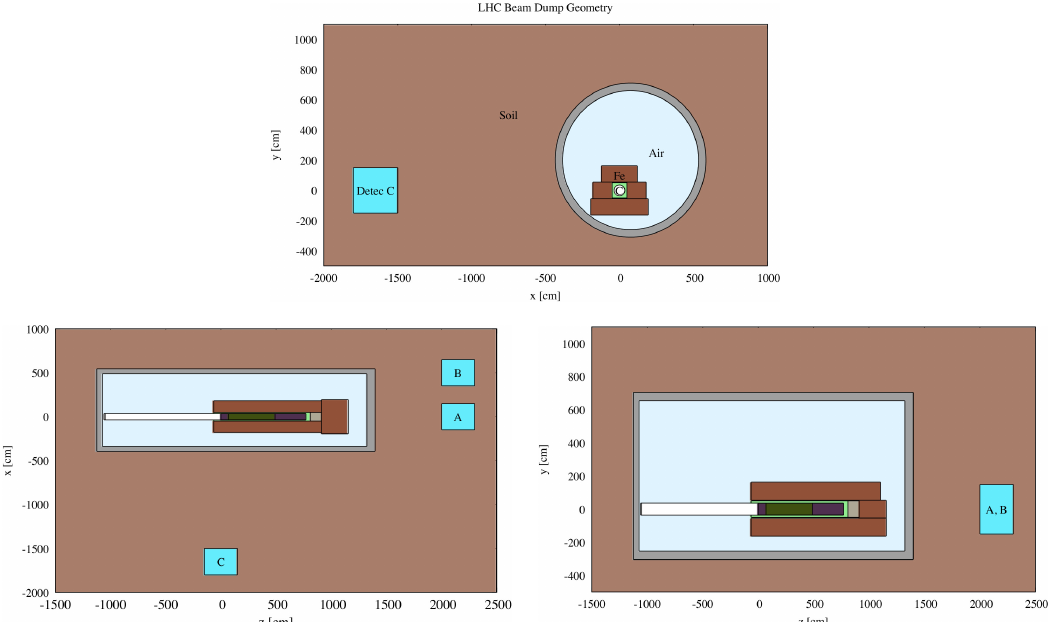
Figure 1. Simplified view of the LHC Beam Dump. In the top panel, the circle labelled “C” represents the Carbon (graphite) target on which the LHC beam is aborted. Such target is divided into three segments with different densities (green and purple), and it is covered by a steel layer (lighter green). The graphite and its cover is surrounded by iron blocks (dark brown) while in the forward direction there is a Titanium window (light gray). The cavern (which we assume is filled with air) is enclosed by a layer of concrete (gray), with soil (light brown) surrounding it. Three potential detector locations (cyan), labelled “A”, “B”, and “C” in the different views, are also